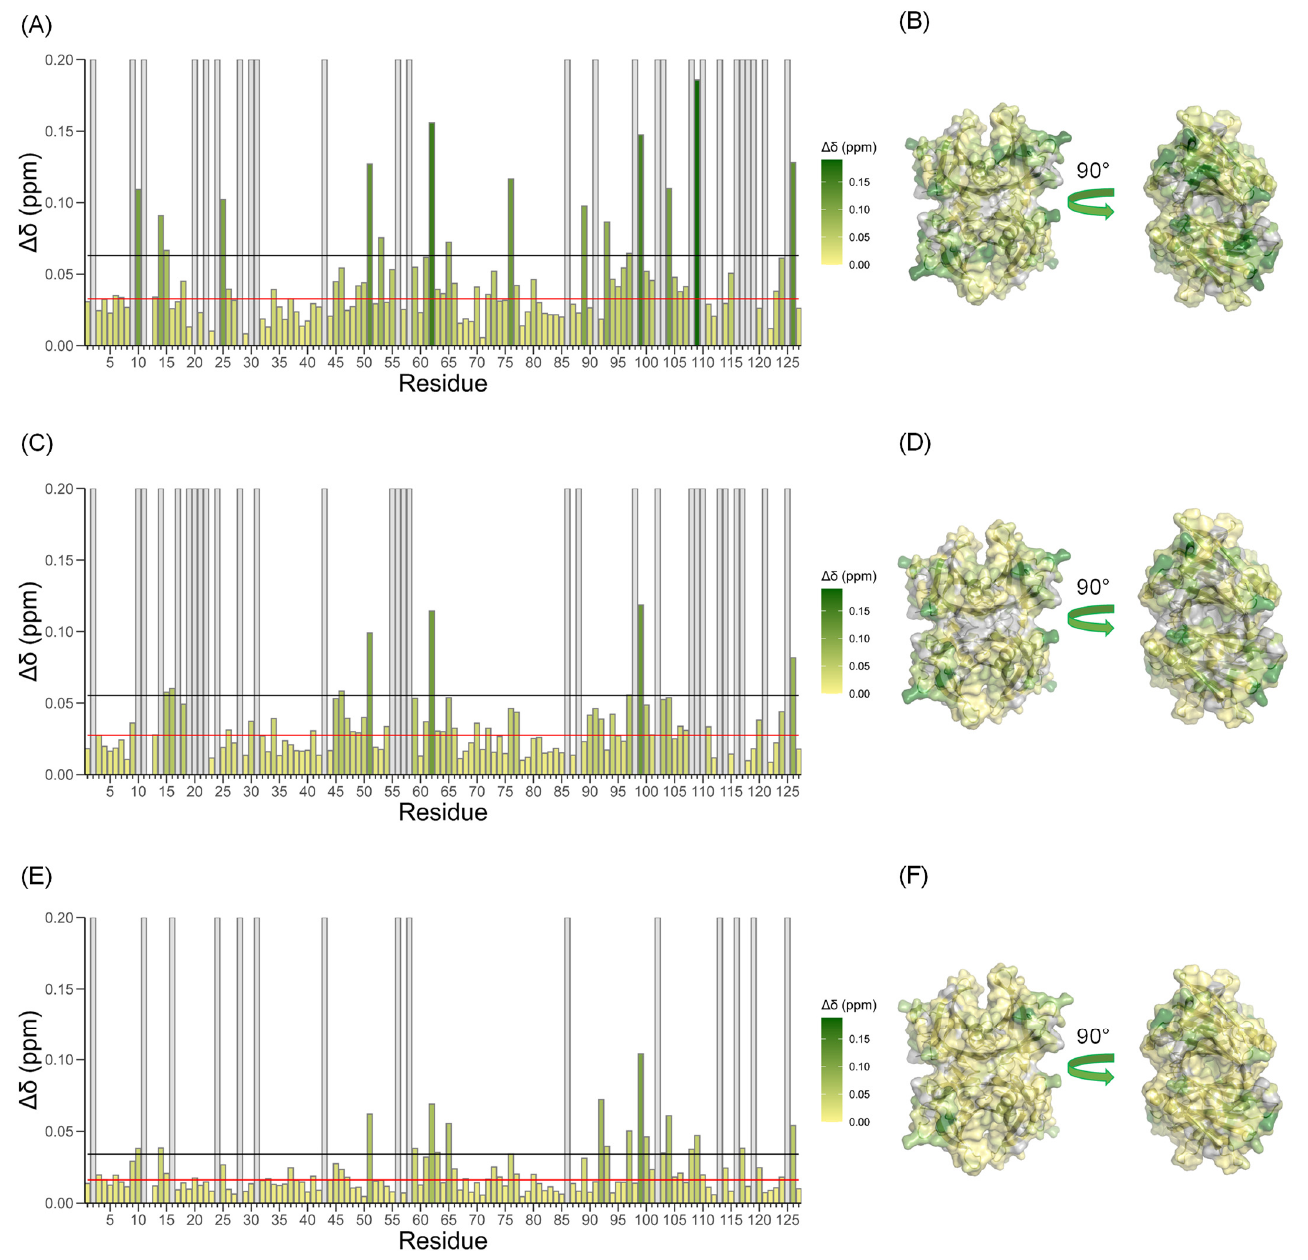
Figure 3. Bar plot of combined NH chemical shift variation recorded at TTR/Ca 2+ = 0.2 at pH 6.5 ( A ), at pH 7.4 ( C ) and at pH 7.4 in the presence of 154 mM NaCl ( E ). Gray bars indicate prolines and residues that could not be followed during titration. The red lines correspond to the average value and the black ones to the average +2 σ . Chemical shift perturbation ( ∆ δ ) observed at pH 6.5 ( B ), at pH 7.4 ( D ) and at pH 7.4 with 154 mM NaCl ( F ) in the presence of CaCl 2 shown in the structure of TTR (pdb: 5cn3) with the same color gradient as in the bar plots.